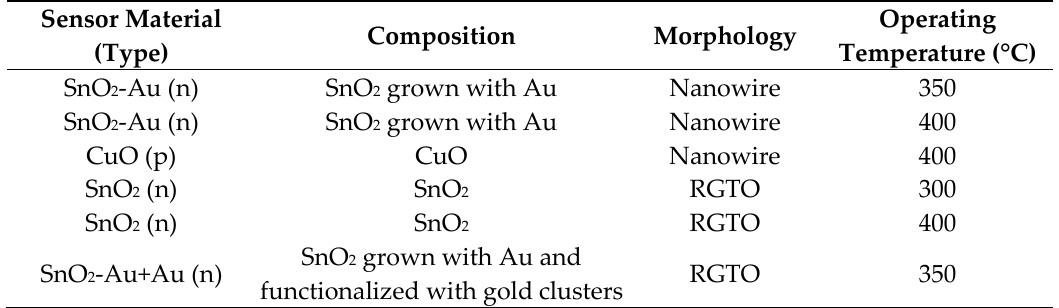
Table 1. Sensors type, composition, morphology, and operating temperature (°C) used in S3 device.